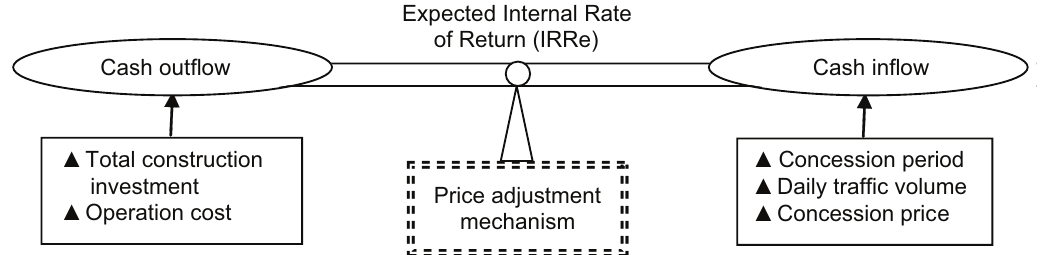
figure 3. Concession pricing parameters for PPP highway projects